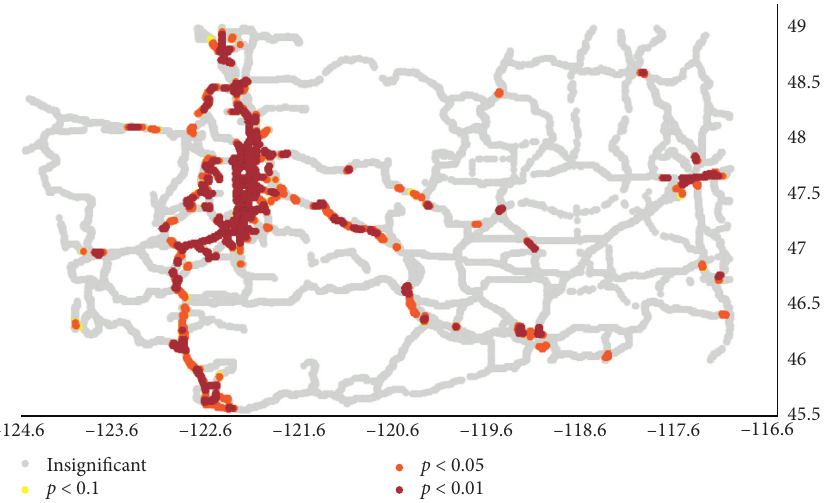
Figure 1: Clusters within the study area (Washington state).